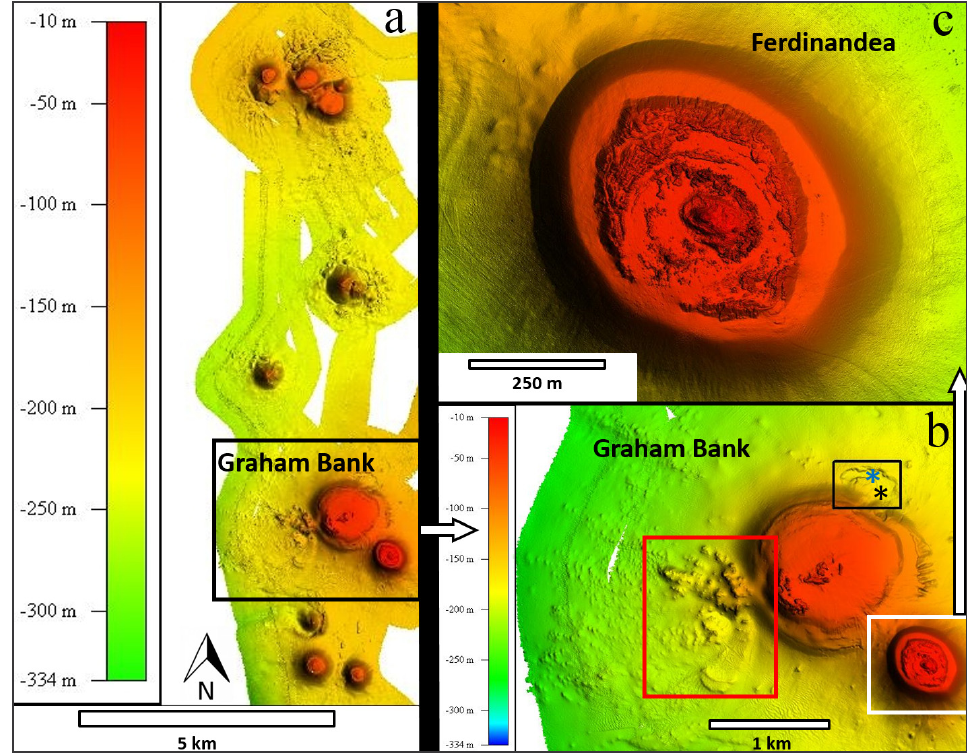
Figure 6. New HR bathymetry images of the volcanic centres identified some 50 km offshore Sciacca area. (a) The NS trending belt including 10 volcanic cones. (b) The Graham Bank with a lava field (red box) and a fumarole field (black box), located, on its western and northeastern side, respectively; the blue and black asterisks indicate the gas and rock sample locations, respectively. (c) The remnant of Ferdinandea